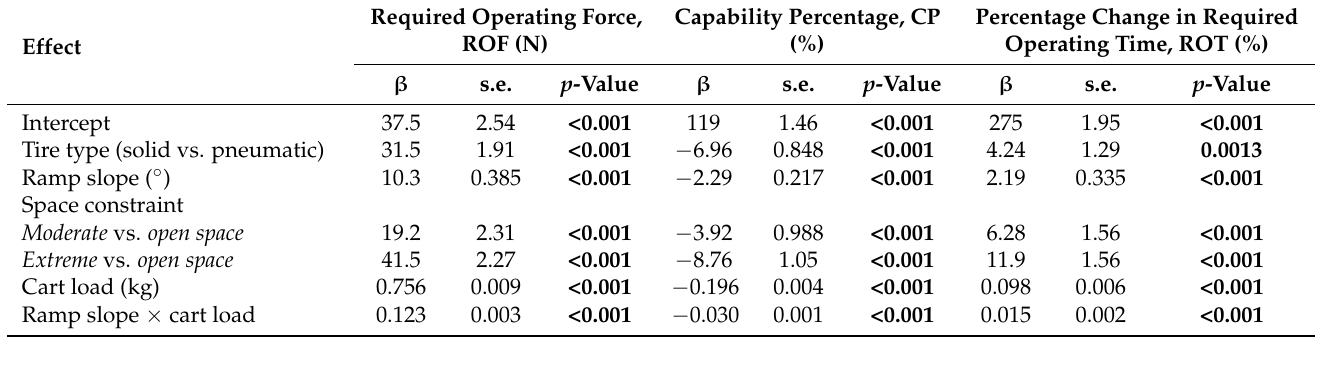
Table 5. Statistical results of Experiment 2b: Regression coefficients ( β ), robust standard errors (s.e.), and p -values from final regression models, featuring four independent variables: tire type (pneumatic tire as baseline), ramp slope (4 ◦ as baseline), space constraint (open space as baseline), and cart load (16 kg as baseline), an interaction term between the ramp slope and cart load, and dependent variables: ROF, CP, and ROT. Bold fonts indicate p -values are less than our significance level 0.05.